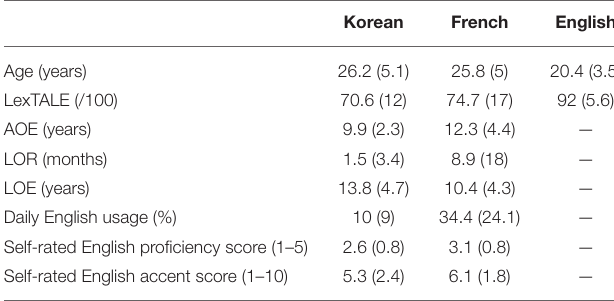
TABLE 1 | Participants’ language background